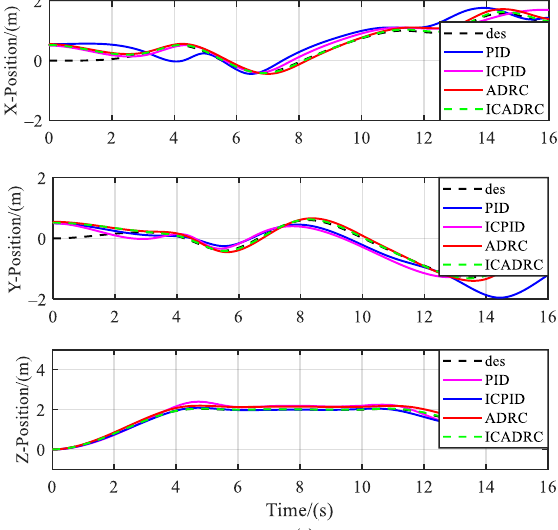
Figure 9. The space trajectories of the quadrotor under different controllers.